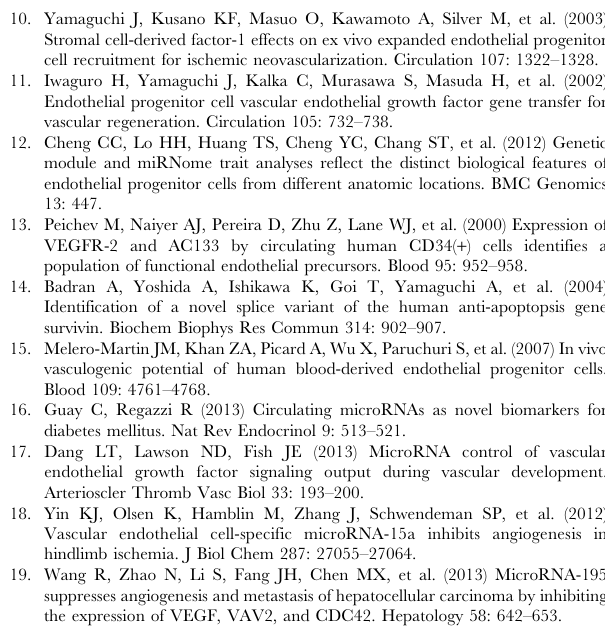
Table S1 Quantitative PCR primer sequences. All primers used for determining the microRNAs or genes expression were listed in the table. Table S2 Baseline characteristics of 55 studied subjects in healthy and CAD patients. The criteria and clinical diagnosis for recruting subjects from either healthy or CAD patients were listed in the table. The value indicated the mean with standard deviation or number with